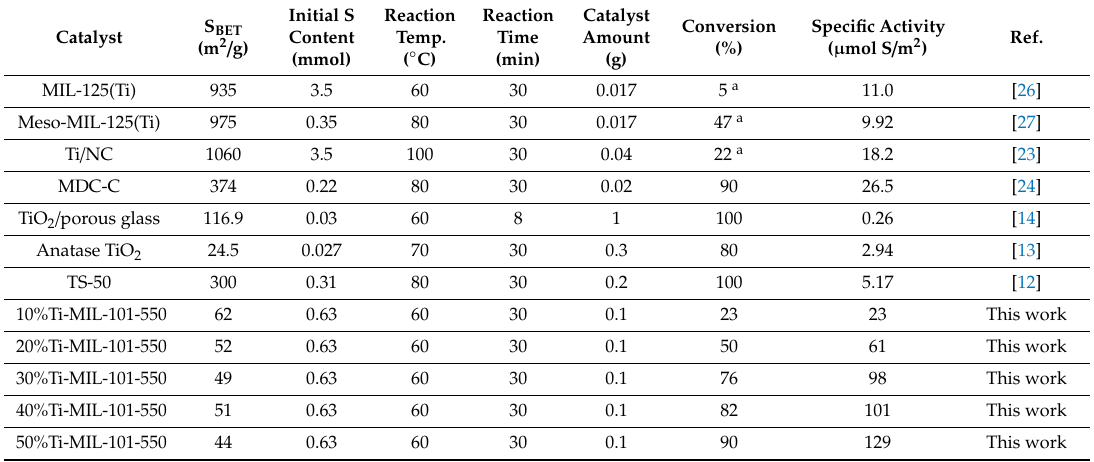
a Conversion calculated based on first-order reaction rate constants.